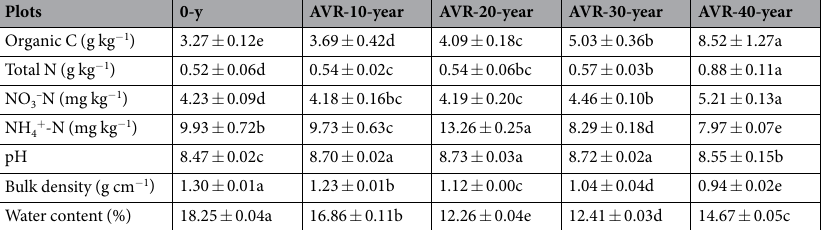
Table 1. Soil physicochemical properties during the process of artificial vegetation restoration. Values are means ± standard error (n = 3). AVR: artificial vegetation restoration. Capital letters denote significant differences between sites ( P < 0.05, ANOVA with Tukey’s HSD) for each